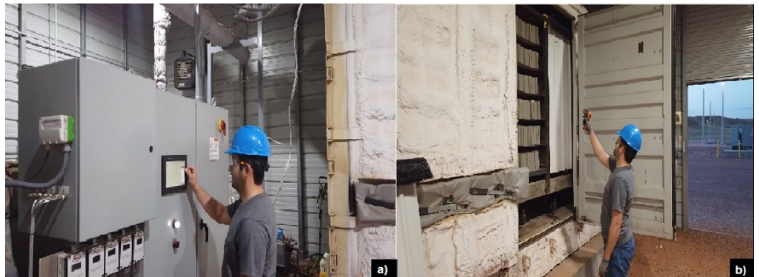
Figure 10. Chamber control: a) CO 2 injection configuration, b) temperature measurement. Source: [[38]].